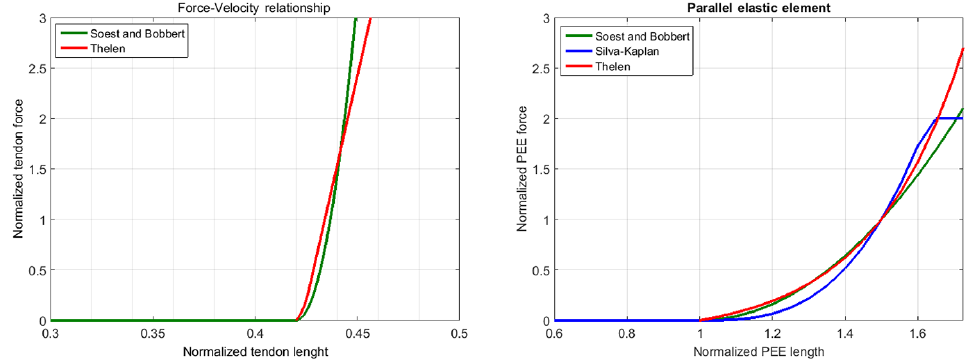
Figure 3. Comparison of the different formulations for (a) Tendon and (b) parallel elastic element. Green solid line: Van Soest and Bobbert. Blue solid line: Kaplan–Silva. Red solid line: